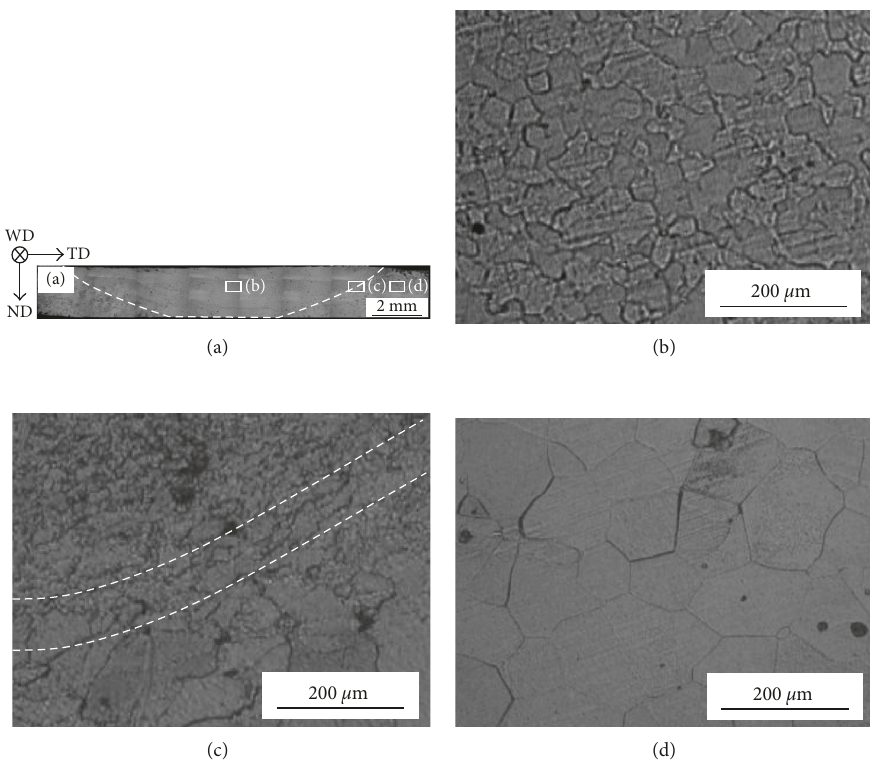
Figure 2: Cross-sectional optical micrographs of the joints showing (a) the overall weld region at low magnification and measurement positions of residual stress (marked by white boxes), and high-magnification images showing (b) SZ, (c) boundary region between SZ and BM, and (d)